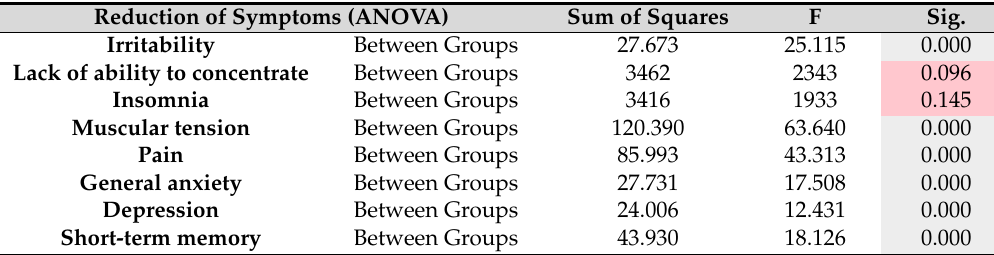
Table 4. Country comparison indicating respondents’ responses to which symptoms can be reduced by contact with nature (green = highly significant differences, orange = significant differences, red = no significant differences).